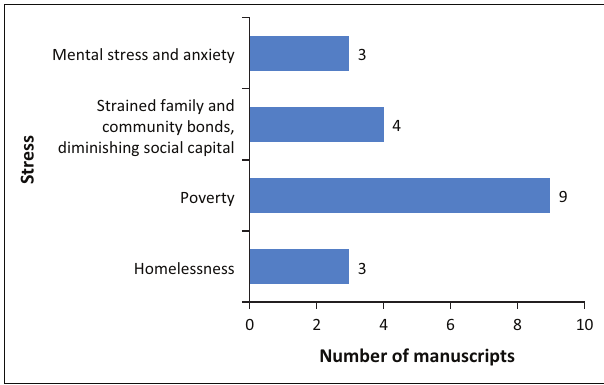
FIGURE 3: Sensitivity of rural communities to the impact of COVID-19. FIG URE 4: Stress factors associated with